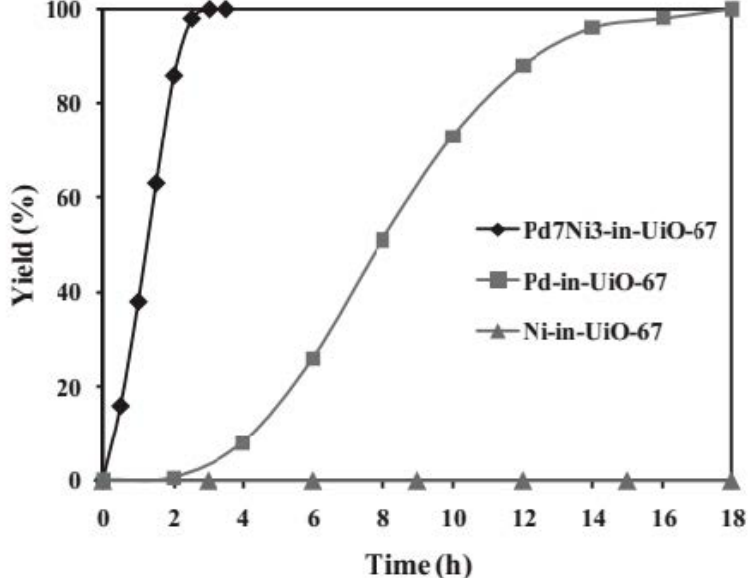
Figure 12. Yield of aniline versus time in the hydrogenation of nitrobenzene using Pd@UiO-67(Zr), Ni@UiO-67(Zr) and Pd 7 Ni 3 @UiO-67(Zr) catalysts. Reproduced with permission from [61].